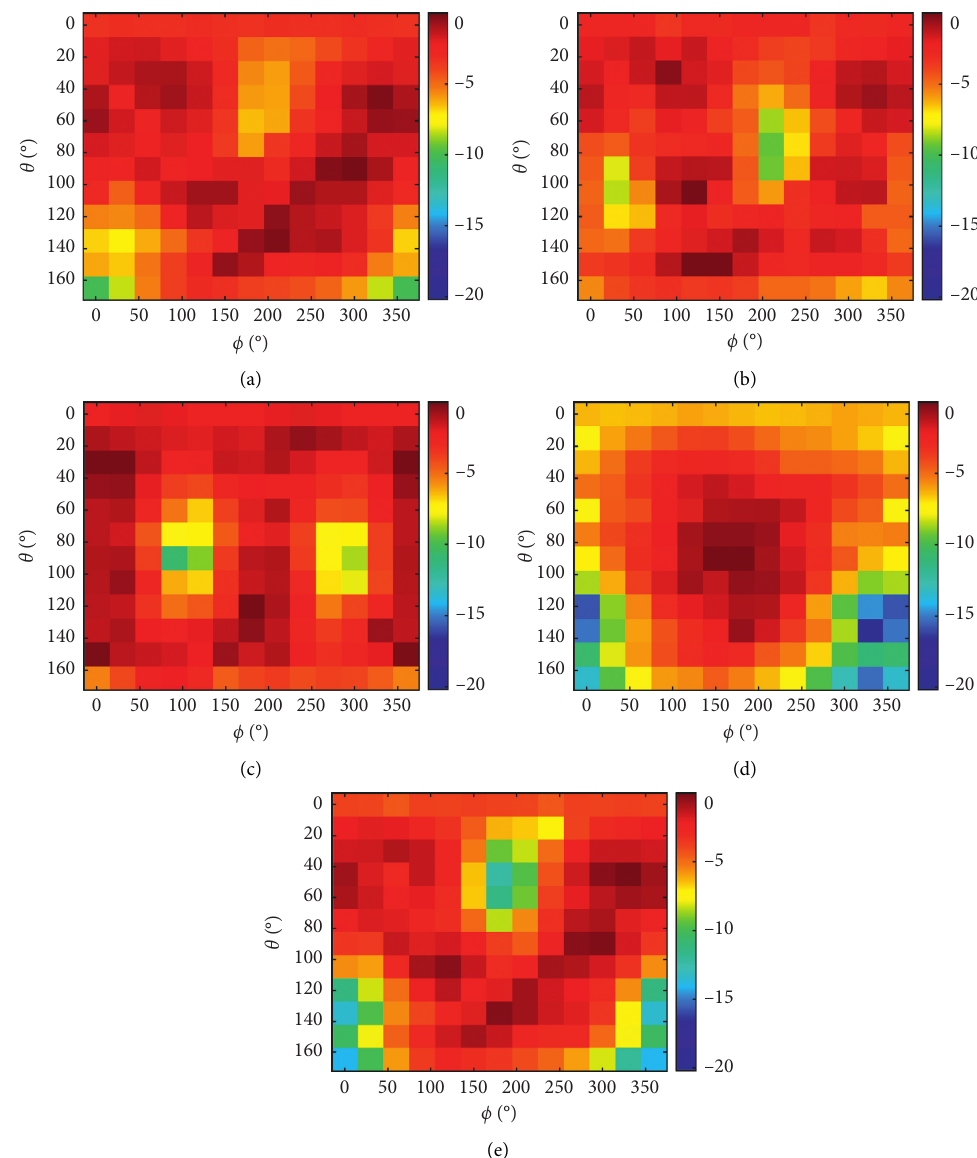
Figure 6: Normalized measured EIRP (in dB) radiation pattern of the right-side earbud in free space at 2.406 GHz: (a) Beoplay E8 2.0; (b) Earin M2; (c) Bose soundsport free; (d) Apple airpods 2; (e) Beoplay E8 3rd